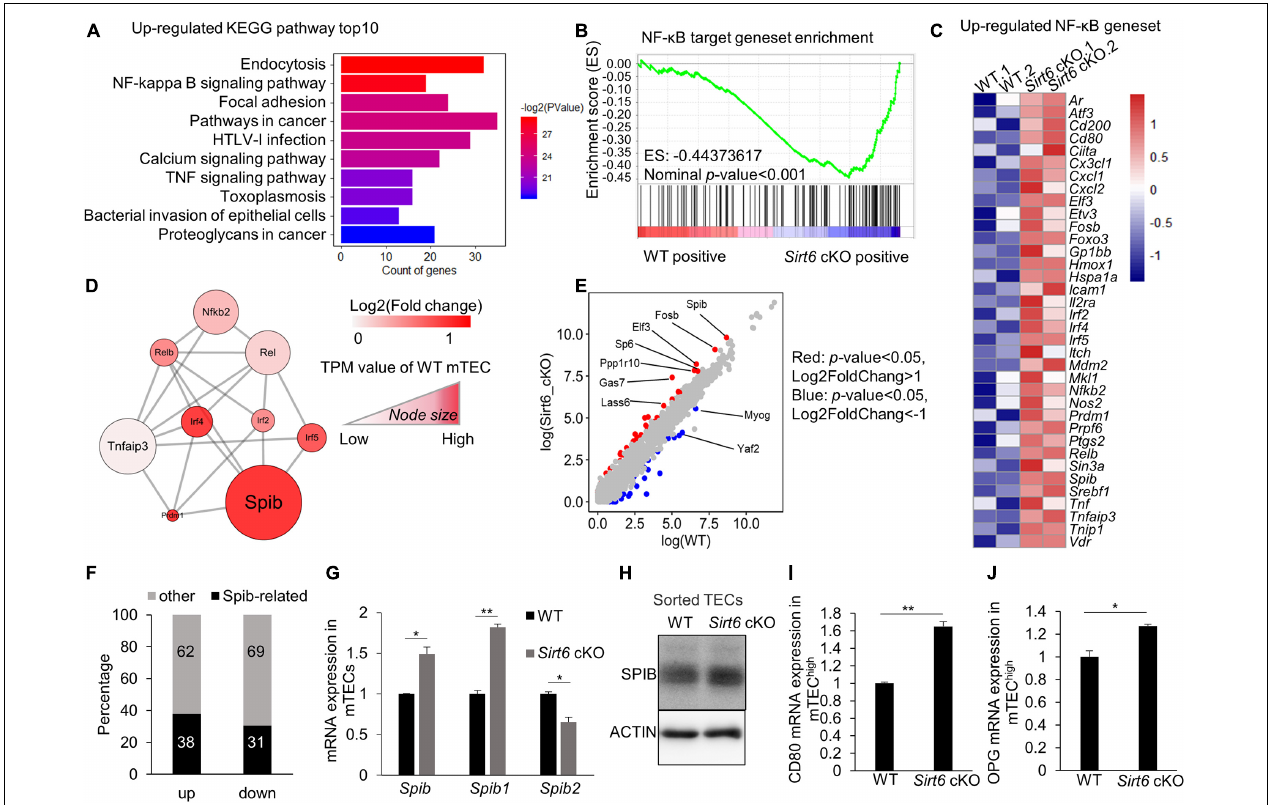
FIGURE 4 | Sirt6 deficiency leads to the activation of NF- κ B pathway which in turn upregulates the expression of Spib . (A) Upregulated genes in Sirt6 deficient mTECs were enriched in KEGG pathways, top10 pathways were ordered by p -value. All pathways were selected under the standard of p < 0.05. (B) GSEA analysis reveals that NF- κ B target geneset had a more positive expression in Sirt6 deficient mTECs defined by the criterion of p < 0.001. (C) The upregulated genes ( p < 0.05) involved in NF- κ B target geneset were performed by heatmap. (D) The molecular network between NF- κ B and its downstream associated upregulated genes was constructed by STRING. All genes belong to transcription factors, color indicated the change of log2FoldChange and Node size indicated the TPM value of wild-type mTECs. (E) The scatter plot showed the difference of TPM values between wild-type and Sirt6 deficient mTECs. The transcription factors with significant changes were color-coded in the plot, red indicated that genes under the criterion of p < 0.05 and log2foldchange > 1 and blue indicated that genes under the criterion of p < 0.05 and log2foldchange < -1. (F) The bar graph shows the changes of SPIB target genes in Sirt6 deficient mTECs relative to wild-type mTECs. Black indicates the proportion of SPIB target genes, which was obtained from the results of ChIP-seq. (G) Expression of Spib and its two different promoters ( Spib1 and Spib2 ) in mTECs (CD45 − EpCAM + UEA-1 + Ly51 − ) sorted from wild-type or Sirt6 cKO mice were measured by quantitative Real-Time PCR analysis. Data were normalized to Hprt mRNA levels. (H) Western blot result for SPIB expression in TECs (CD45 − EpCAM + ) sorted from wild-type or Sirt6 cKO mice. (I,J) Quantitative Real-Time PCR analysis of Opg (I) and Cd80 (J) mRNA expression in mTEC high (CD45 − EpCAM + UEA-1 + CD80 + MHC II high ) sorted from wild-type and Sirt6 cKO mice. Data were normalized to Hprt mRNA levels. * p < 0.05 and ** p < 0.01 (Student’s t